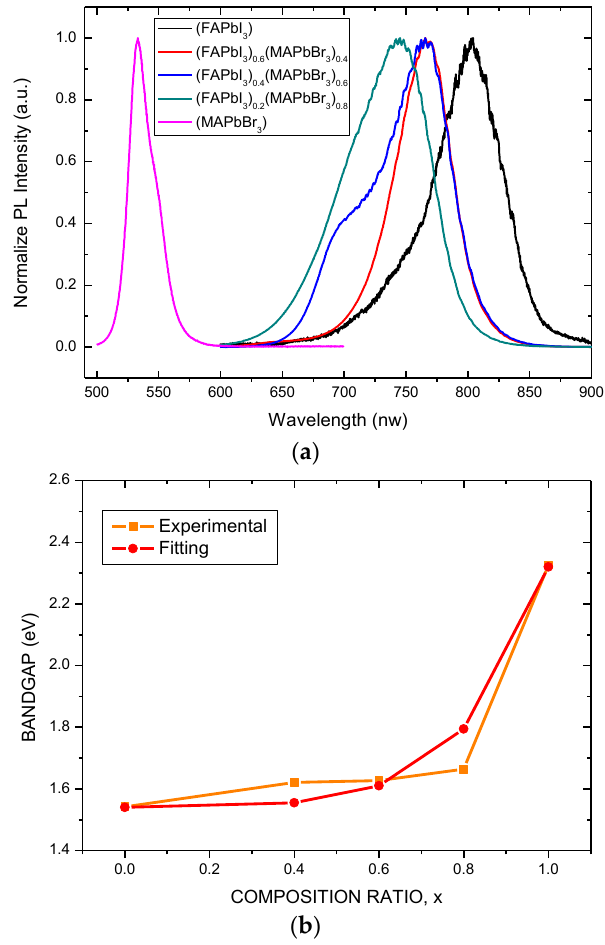
Figure 4. ( a ) Photoluminescence (PL) spectra of mixed (FAPbI 3 ) 1− x (MAPbBr 3 ) x perovskite films with various values of x. ( b ) Bandgap of mixed (FAPbI 3 ) 1− x (MAPbBr 3 ) x perovskite films, estimated